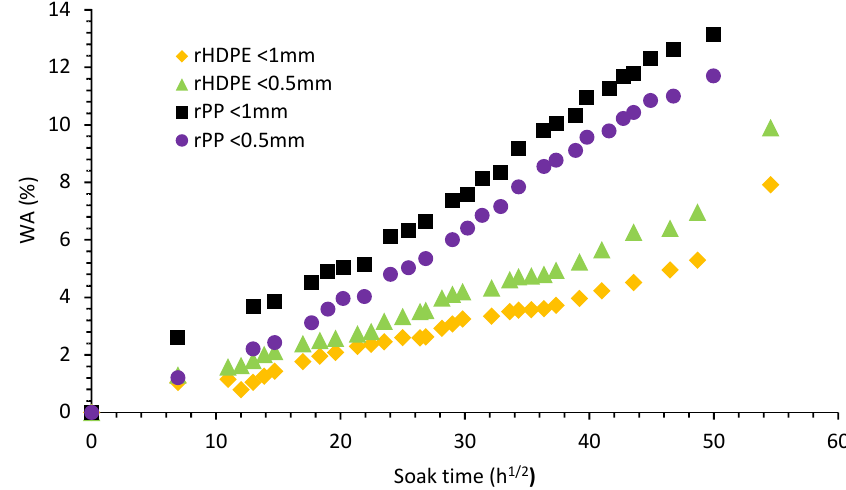
Figure 10. Water soak of polyolefin composites as a function of time. Table 5. Water soak properties of polyolefin composites.